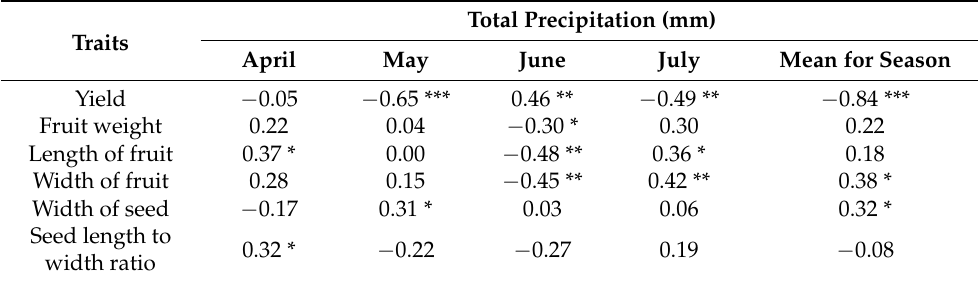
Table 4. Correlation coefficients between yield and morphological characteristics of fruits and seeds, and total precipitation in the months of vegetation from April to July in 2019–2022. Total Precipitation (mm) Traits